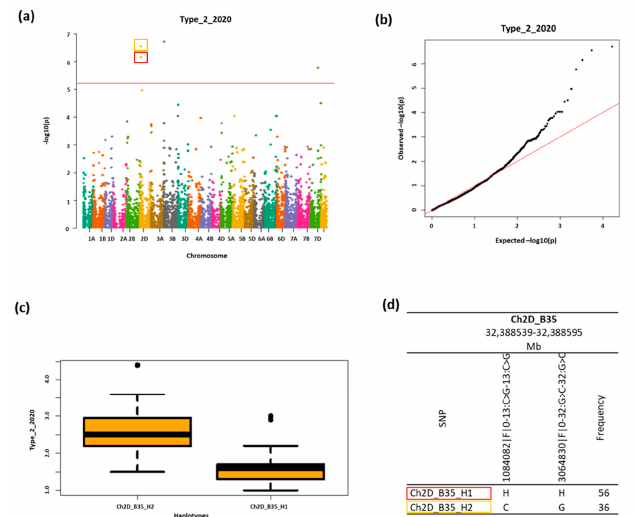
Figure 5. ( a ) Manhattan plot on 21 wheat chromosomes for Type_2_2020 trait. The red horizontal dash represents the GWAS threshold of − log( p ) = 5.22 for Bonferroni correction and dots above the red line indicate significant MTAs. ( b ) Q-Q plot for GWAS results for Type_2_2020 trait. ( c ) Box- plots indicating the phenotype value of Type_2_2020 trait corresponding to the two haplotypes (H1 and H2) in the same haploblock (Ch2D_B35) on chromosome 2D. ( d ) Haplotype block based on two SNP markers on chromosome 2D; both haplotypes are significantly associated with the Type_2_2020 trait (MTA). Frequency show occurrence (percentage) of haplotypes in the group of families.